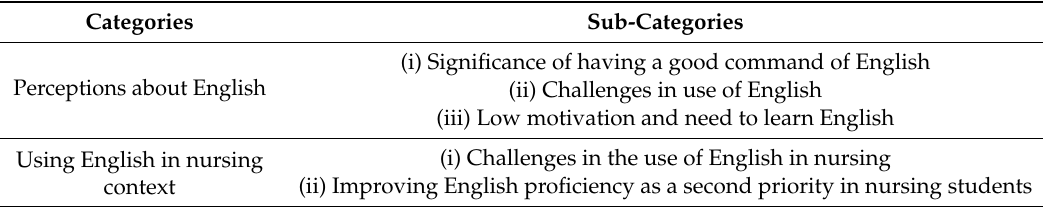
Table 2. Summary of categories and